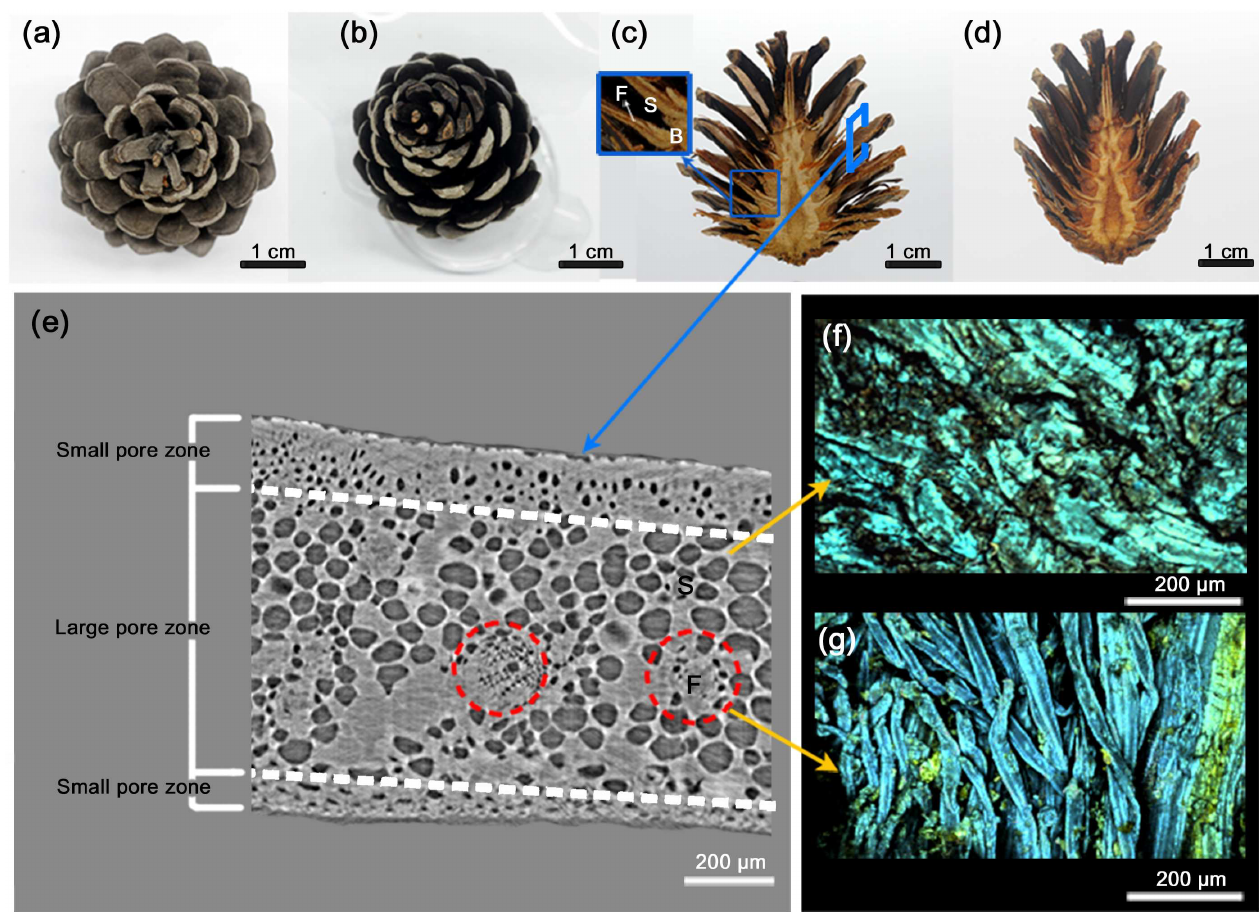
Fig 1. Morphological characteristics of pine cone scales. (a) Pine cone scales fully openon sunny dry days. (b) When pine cone gets wet, pine cone folds its scales (c) Hemisected pine cone shows layered structure. In dry condition, scales are fully opened. Pine cone scale consists of fibers (F) and sclerids (S). ‘B’ signifiesbract scale. (d) Pine cone fold its scale after wetting. (e) Cross sectional image of scale is capturedusing X-ray microscopy. The large pores are surroundedby small pores like layer structure. Fibers penetrate into the scale structure. ‘S’ and ‘F’ signify sclerids and fibers, respectively. Anatomic 3D structure of sclerid (f) and fiber (g) are investigated3-dimensionally using multi-photonmicroscopy. The sclerid has dense structure like rock, while the fibers are